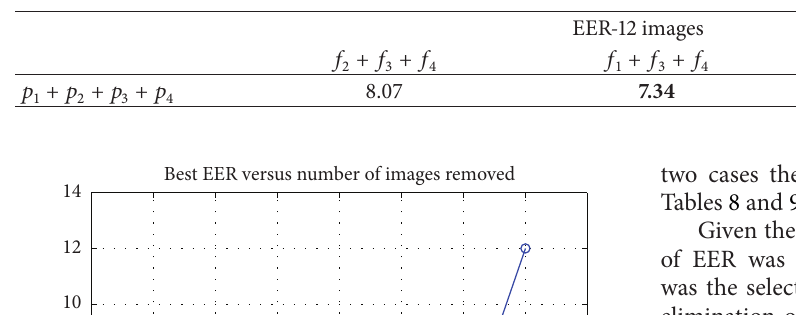
Table 7: Equal error rate using 12 images, discarding a frequency.